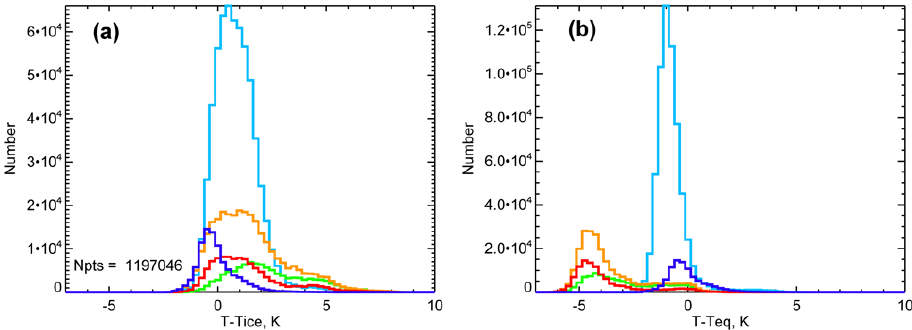
Fig. 8. Histograms of CALIOP PSC observations at 490K potential temperature during five Arctic winters (2006–2011) as a function of